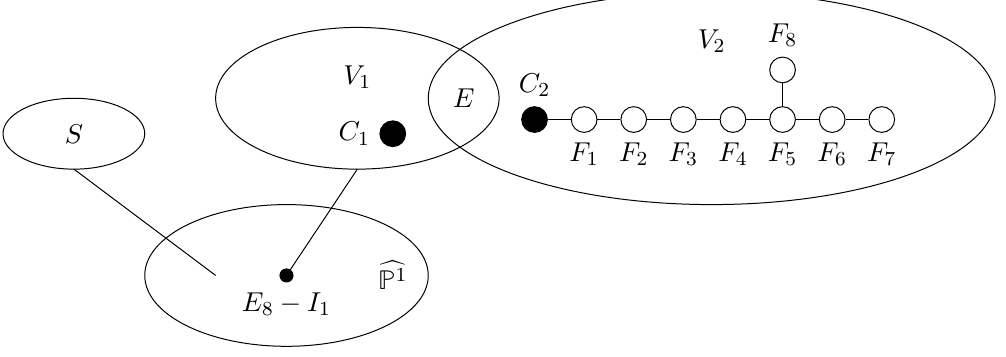
Figure 1 . The geometry of Z − with k = 1 and V 2 = gdP 8 . We have C 1 · C 1 = C 2 · C 2 = − 1 and F i · F i = − 2